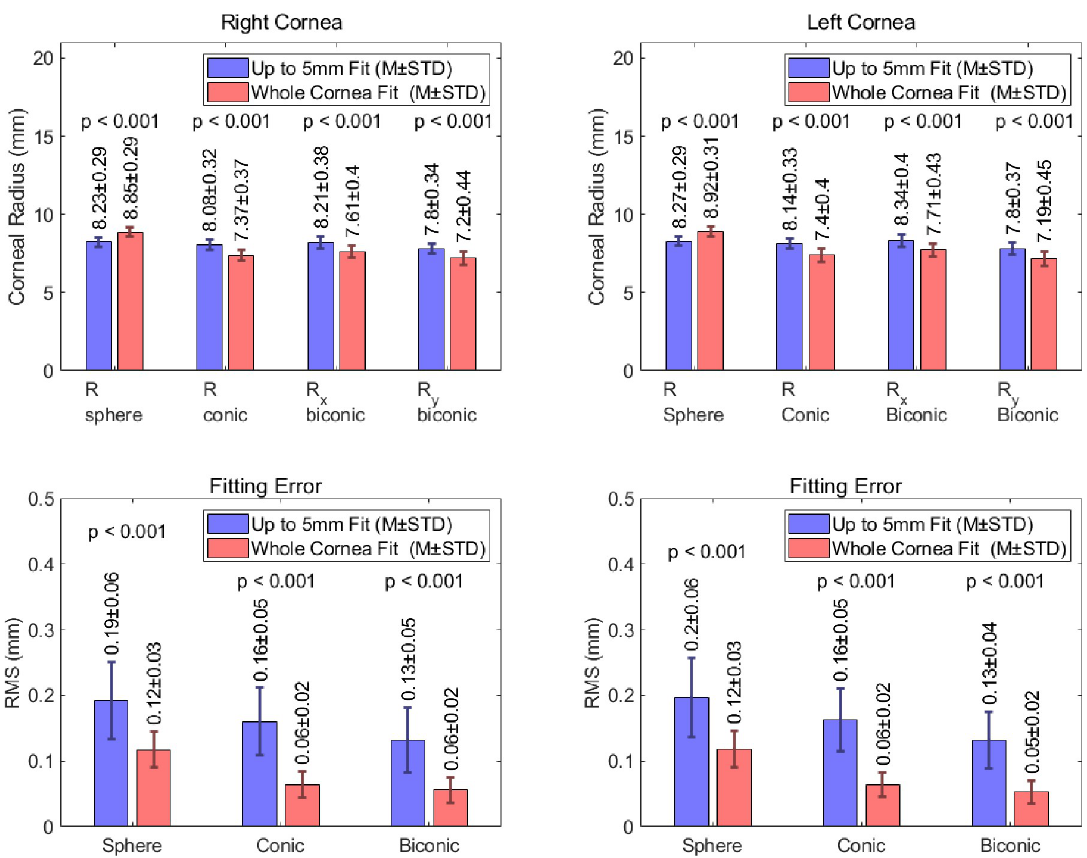
Fig 4. Corneal radius of curvature values measured from corneal models produced using spherical, conic and biconic fitting procedures. Fitting errors representing the RMS error between the values produced by the model and those obtained